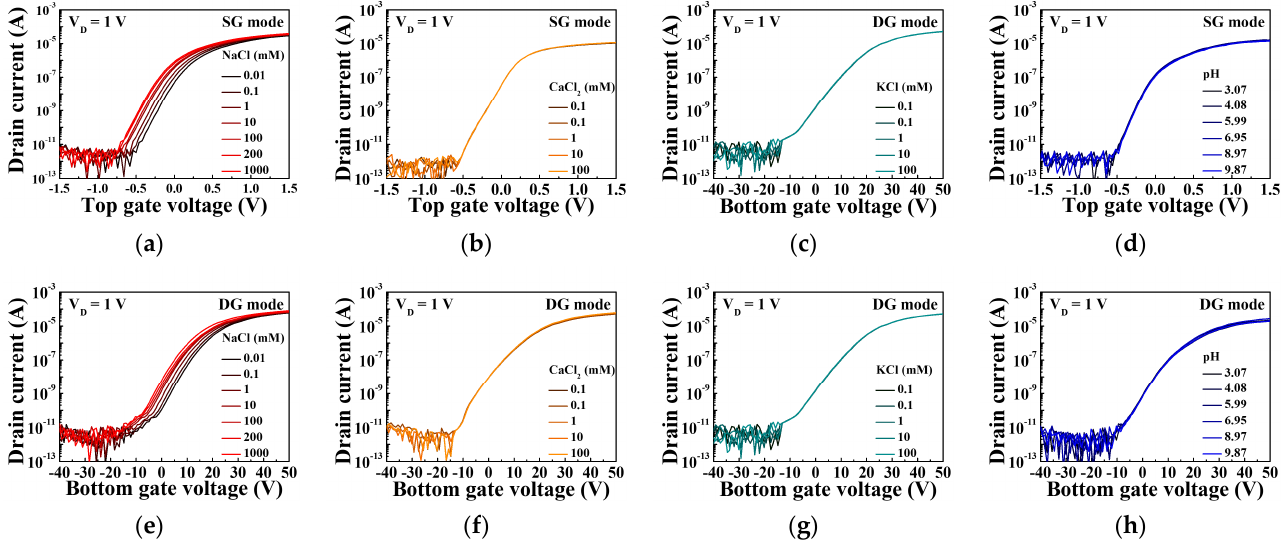
Figure 8. Transfer characteristic curves of the sodium ion sensor based on a SiNW channel DG FET with a sodium-selective membrane EG in various buffer solutions: SG mode operations for the ( a ) NaCl, ( b ) CaCl 2 , ( c ) KCl, and ( d ) pH buffer solutions, and DG mode operations for the ( e ) NaCl, ( f ) CaCl 2 , ( g ) KCl, and ( h ) pH buffer solutions.